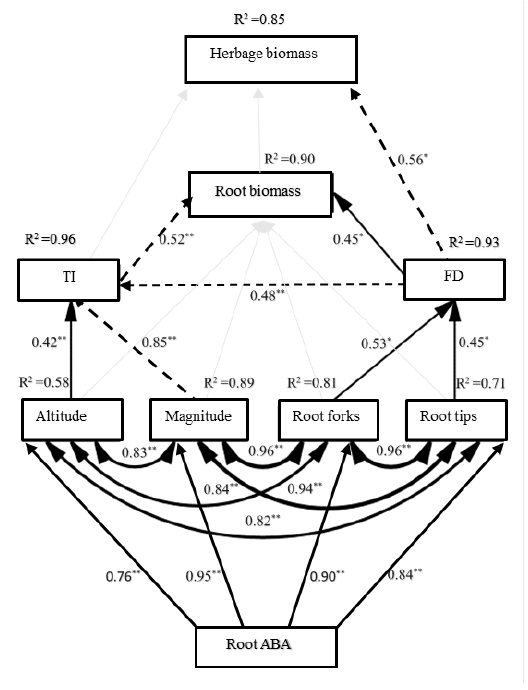
Figure 9. Structural equation model (SEM) based on the effect of alfalfa root ABA content on altitude, magnitude, number of forks, number of root tips, topology index (TI), fractal dimension (FD), root biomass, and herbage biomass under various soil water content treatments (χ 2 = 8.501, df = 8, χ 2 /df = 1.063, P = 0.386, RMSEA = 0.057, GFI = 0.901). Continuous and dashed arrows indicate positive and negative relationships, respectively. Width of the arrows is proportional to the strength of the path coefficients. As in other linear models, R 2 indicates the proportion of variance explained by the variables. The R 2 value is shown above every response variable in the model. Black and gray arrows indicate significant and non-significant correlations, respectively. The numbers beside arrows are the correlation coefficient between two indicators. * p < 0.05, ** p <